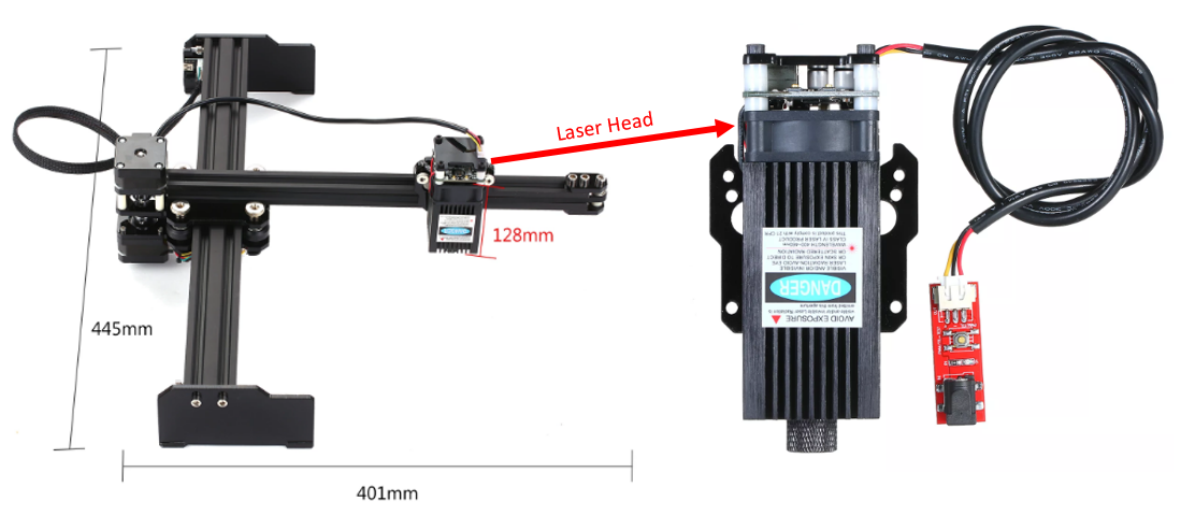
Figure 3. Laser-based weed-killing system ( left ) and 20W laser head With adjustable power and focus ( right